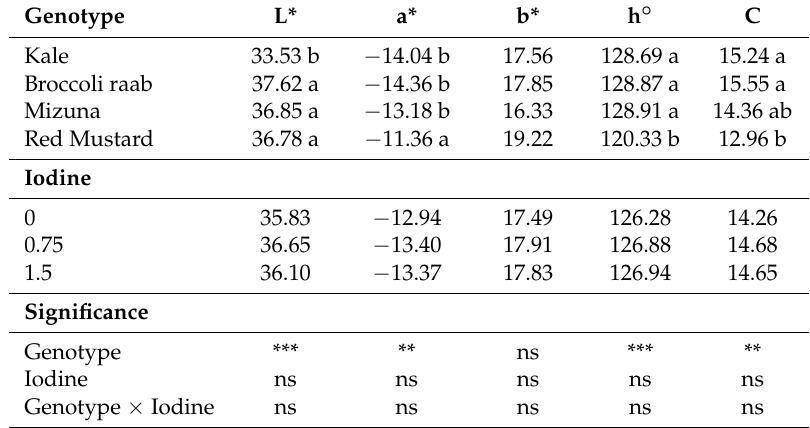
Table 3. Color parameters of raw leaves in Brassica genotypes supplied with different levels of I in the NS.